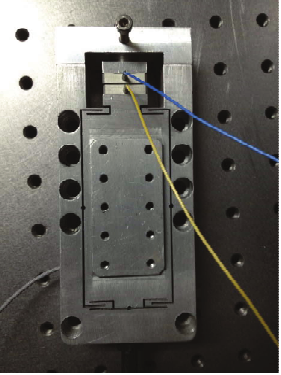
Figure 3. Photo of the micropositioning stage.